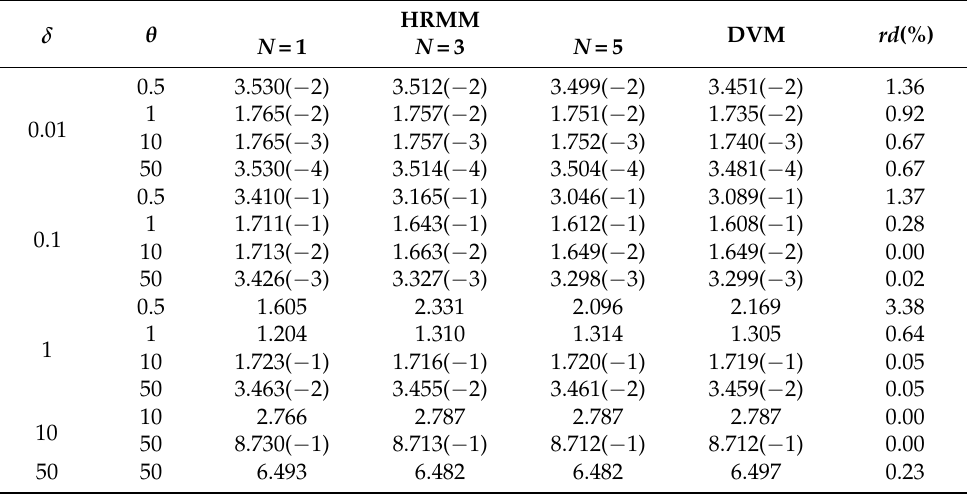
Table 7. Oscillatory Couette flow; shear stress phase (rad) at the stationary wall p xy,P ( y = H ) for various values of δ and θ based on the HRMM, with N = 1,3,5 and the DVM, along with the relative difference between corresponding